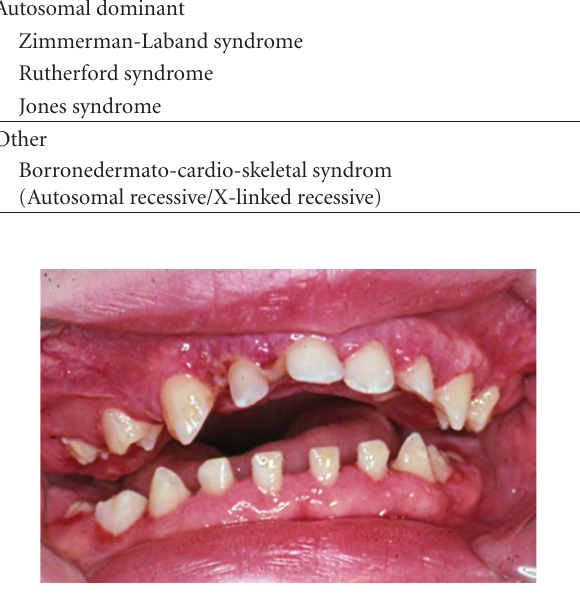
Figure 4: Recurrence of gingival hyperplasia at 6 years of age (primary